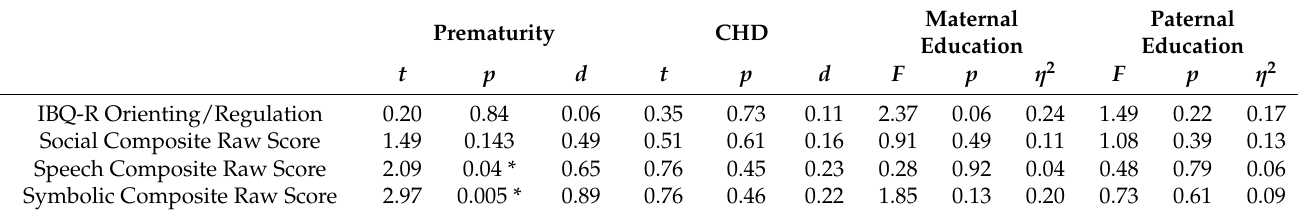
Table 3. Within-group differences based on biomedical comorbidity and caregiver education